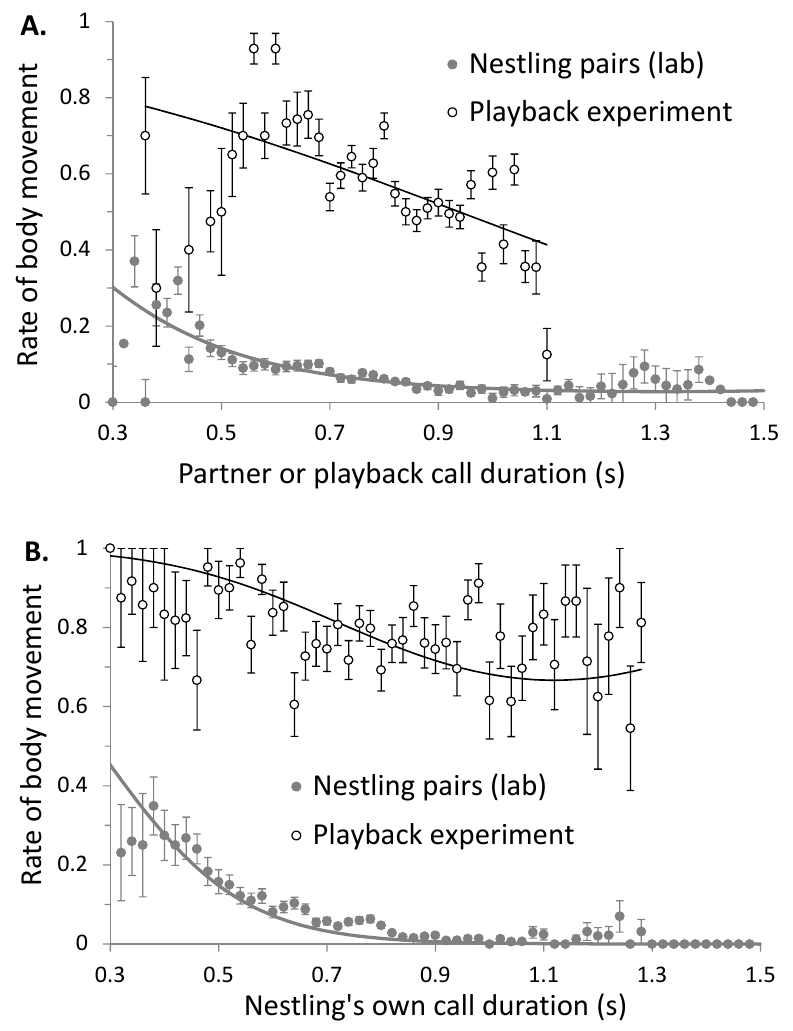
Figure 3. Body movements (occurrence in each minute) according to the duration of negotiation calls performed by the ( A ) partner and ( B ) the focal barn owl nestling itself. Behaviors were recorded in pairs of nestlings in the laboratory (grey symbols, experiment 2) and in singleton nestlings to which we broadcast playback calls of di ff erent durations (open symbols, experiment 3). Bars represent standard errors and lines are estimates of the models.